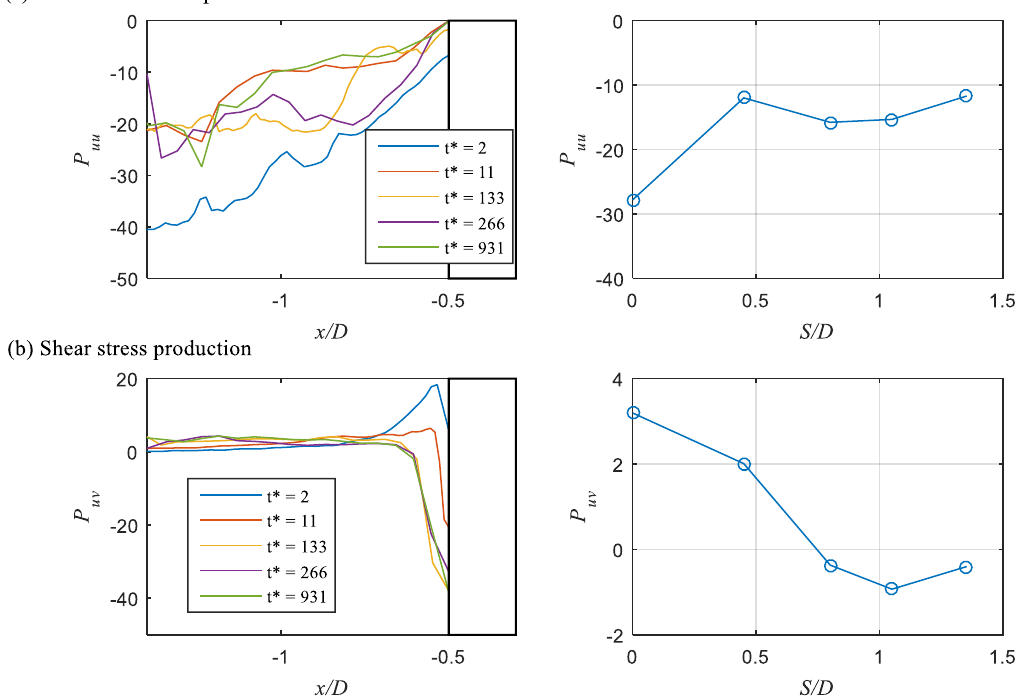
Figure 16. Production of turbulent kinetic energy along the center line at different time in the pier scouring process and the corresponding space-averaged value versus dimensionless pier scour depth. ( a ) streamwise stress production, ( b ) shear stress production.